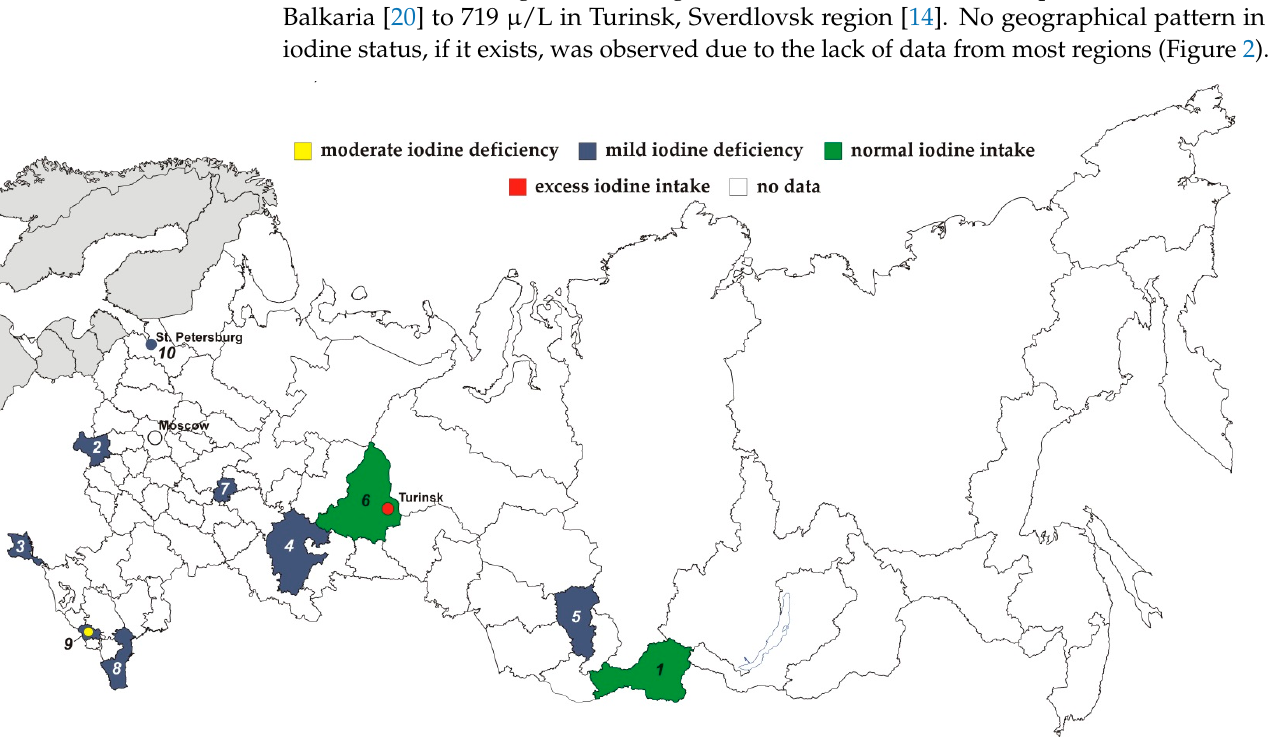
Figure 2. Iodine status among 6–12-year-old children in Russia. 1—Republic of Tyva; 2—Bryansk region; 3—Republic of Crimea; 4—Republic of Bashkortostan; 5—Kemerovo region; 6—Sverdlovsk region; 7—Republic of Chuvash; 8—Republic of Dagestan; 9—Republic of Kabardino-Balkaria; 10—St. Petersburg (city).